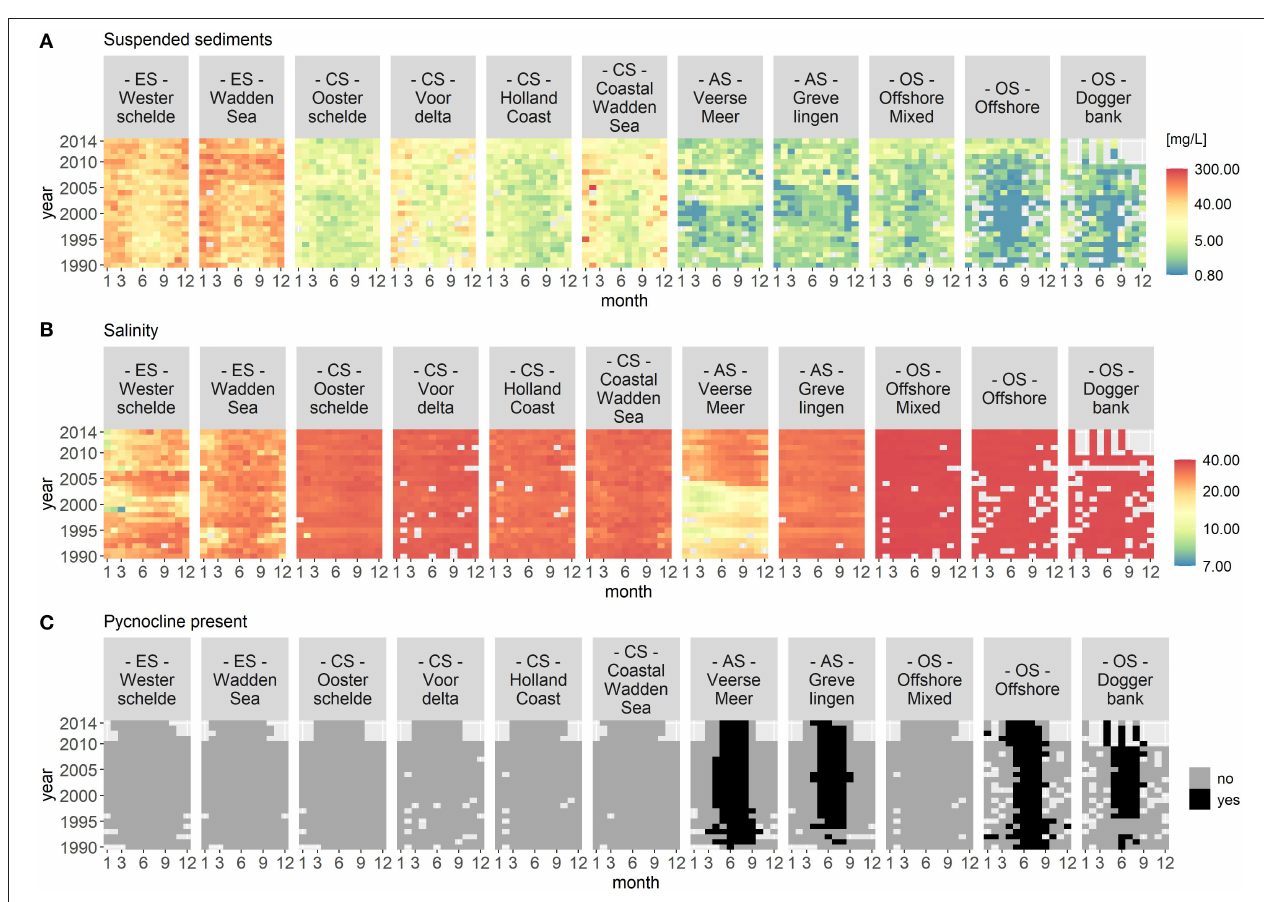
FIGURE 3 | Monthly median of suspended sediments (A) , salinity (B) , and stratification (C) for each location class per year. Suspended sediment and salinity use a logarithmic color scale. The location classes are grouped into estuary (ES), coastal (CS), anthropogenically modified (AS), and offshore systems (OS). The figures display gradients (left to right) from the estuary systems (ES) to the offshore systems (OS). In (C) , the color black indicates that a pycnocline was detected at the location classes Veerse Meer, Grevelingen, Offshore, and